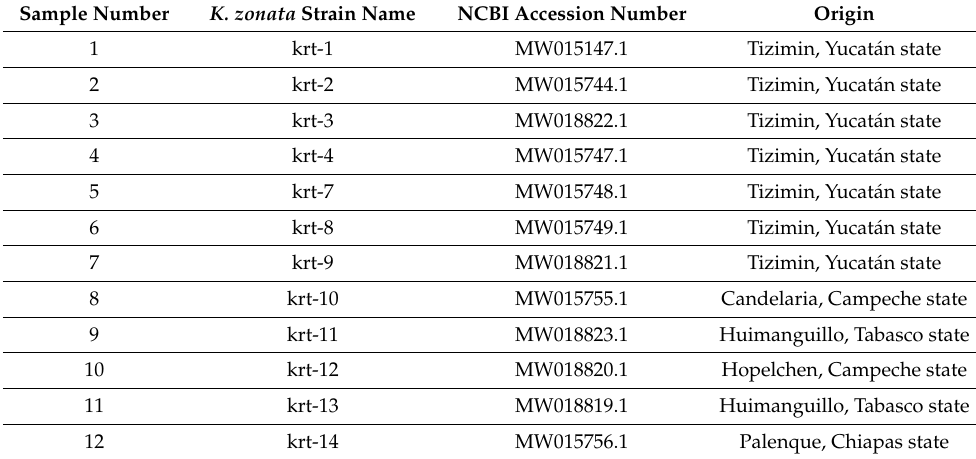
Table 2. Strain name, NCBI accession number and locality of origin of Kretzschmaria zonata isolates used in this